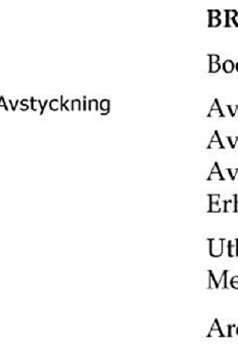
Figure 4. Cadastral map of Multihuset, Malmö, Sweden (Source: Malmö municipality).